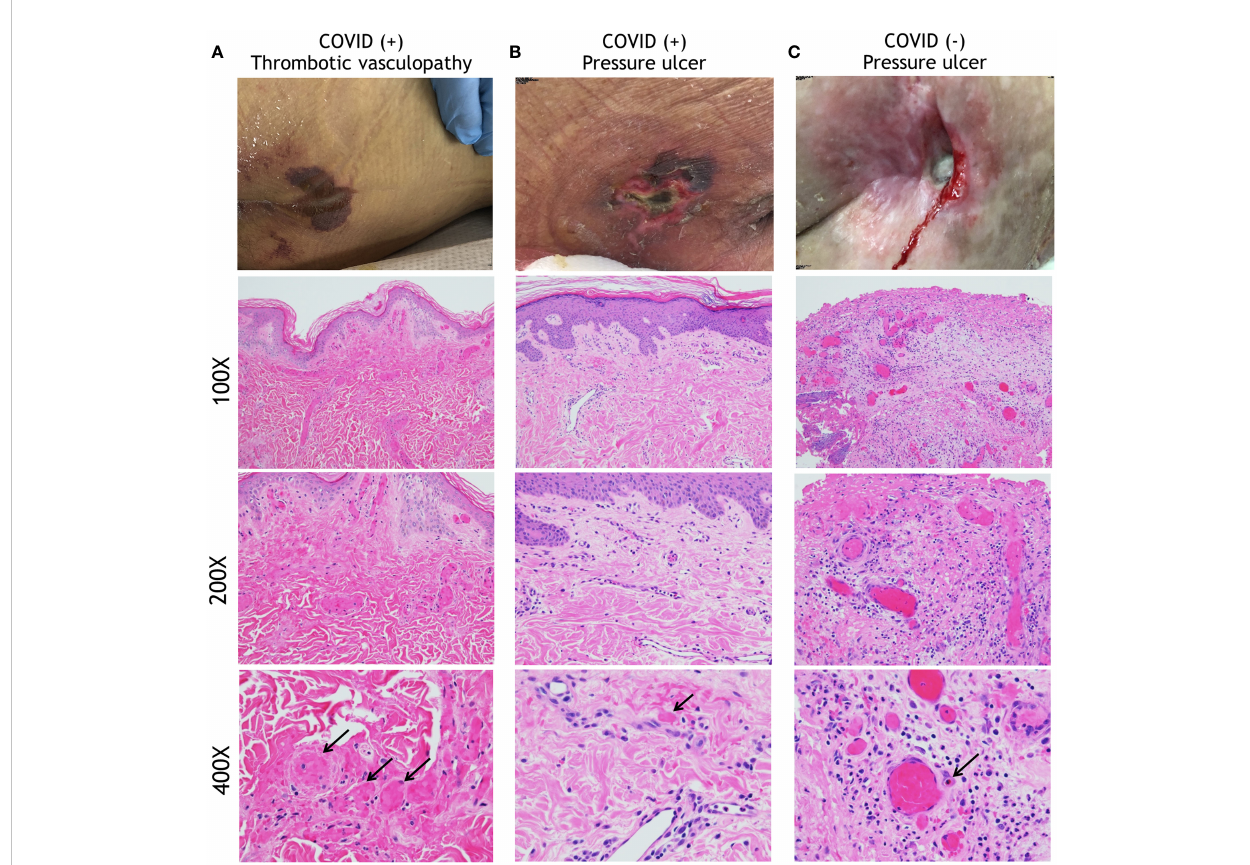
FIGURE 1 Histopathology analysis of HASPIs. (A) COVID-19-related Thrombotic Vasculopathy. A man in his 30s was intubated in the ICU due to severe COVID-19 with an acute purpuric rash on the buttocks that subsequently ulcerated. A low-power photomicrograph (100X) reveals a relatively normal and intact epidermis with diffuse fi brin thrombi involving super fi cial and deep dermal vessels. A higher power image (200X) further highlights diffuse fi brin thrombi and occasional in fl ammatory cells within the dermis. At even higher power (400X) occasional neutrophils and leukocytoclasis can be seen. (B) A woman in her 80s who developed a sacral ulcer with surrounding purpura in the setting of COVID-19 after 6 weeks of intubation. At low power (100X), a photomicrograph displays an intact epidermis with mostly patent vascular spaces in the dermis. At higher power (200X), a sparse super fi cial dermal in fl ammatory in fi ltrate with occasional neutrophils is noted. A 400X image reveals a rare vascular thrombosis. Other vessels display intact neutrophils within their lumens. (C) A pressure ulcer in a COVID-19(-), wheelchair-bound man in his 70s. A low-power (100X) image reveals an ulcer with super fi cial fi brin necrosis, mixed in fl ammation, and dilated vascular spaces with congestion and occasional fi brin thrombi. A higher power (200X) image reveals centrally located vessels with congestion and peripheral vessels with fi brin thrombi. At 400X magni fi cation, a mixed in fl ammatory in fi ltrate is seen surrounding vessels that are either congested or with contained fi brin thrombi. Neutrophils are intact, without obvious leukocytoclasis. An eosinophil is present within a vascular lumen (arrow, (400X)). Eosinophils were often seen in COVID-19(-)-associated ulcer specimens, either within vascular lumina or in the